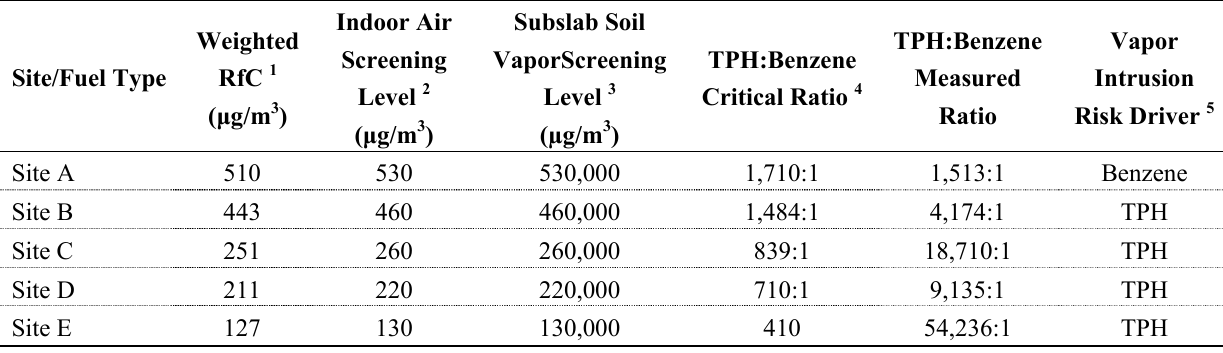
Table 10. Weighted TPH Reference Concentration and example TPH subslab soil vapor screening levels for soil vapor samples collected in the Hawaii DOH petroleum vapor